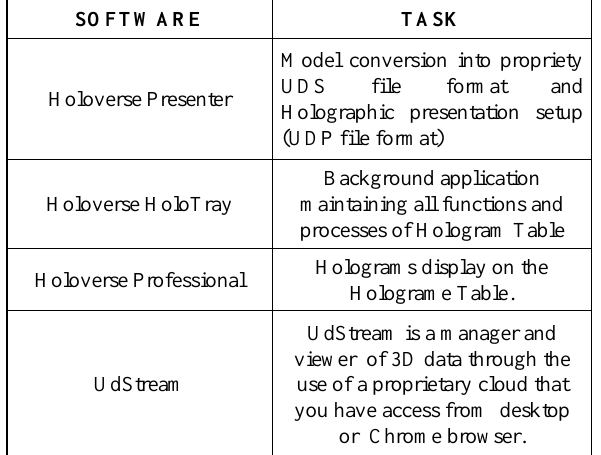
Figure 6. Revit Model on Euclideon